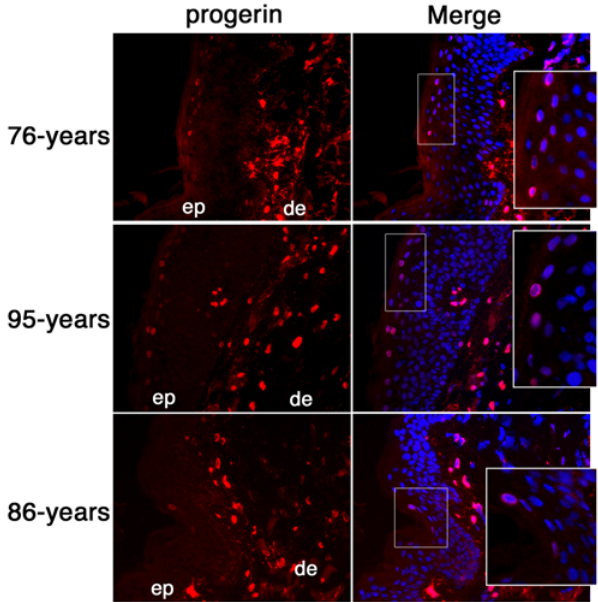
Figure 5. Progerin detection in a subset of terminally differentiated keratinocytes. Left panels correspond to anti-progerin monoclonal antibody staining of skin sections derived from individuals of indicated age. Right panels correspond to the merged signal of dapi and progerin signals. Square indicates the zoomed in region of the epidermis. ep denotes epidermis, and de the